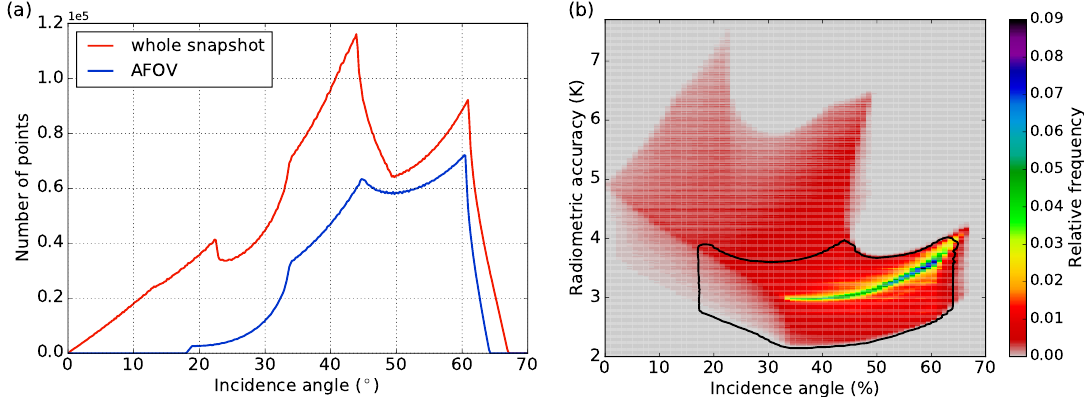
Figure 1. ( a ) frequency distribution of SMOS incidence angles for data from whole snapshots (red) and from the alias-free field of view only (blue); ( b ) two-dimensional frequency distribution of SMOS incidence angles and corresponding radiometric accuracies for data from whole snapshots. The black contour marks the alias-free field-of-view (AFOV). Both figures are based on the SMOS L1C sea product north of 50 ◦ N on 1 March